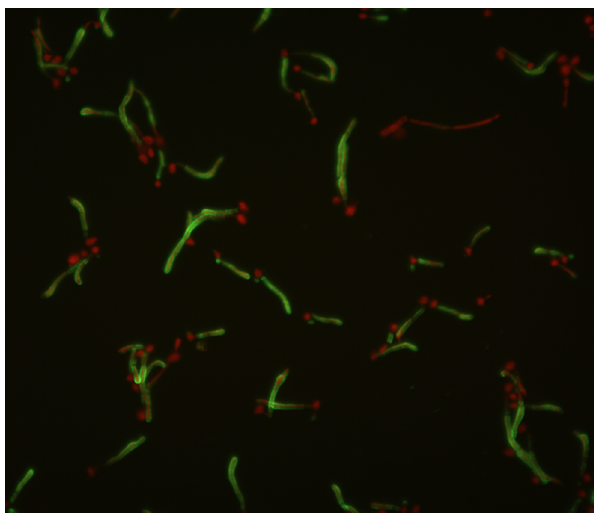
Figure 1. Binding of mAb K20 to Candida albicans cell wall, particularly on germ tubes and budding cells. MAb K20 labeled with biotin was used in the immunofluorescence assay with strepta- vidin-fluorescein.